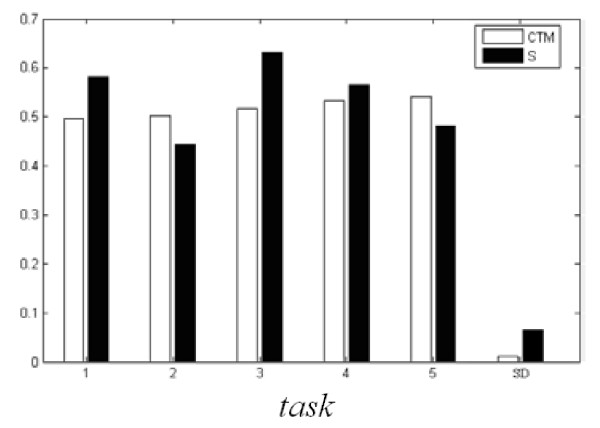
Statistic average histogram of CTM and S of 5 tasks of subject 1 (SD denotes standard deviation).